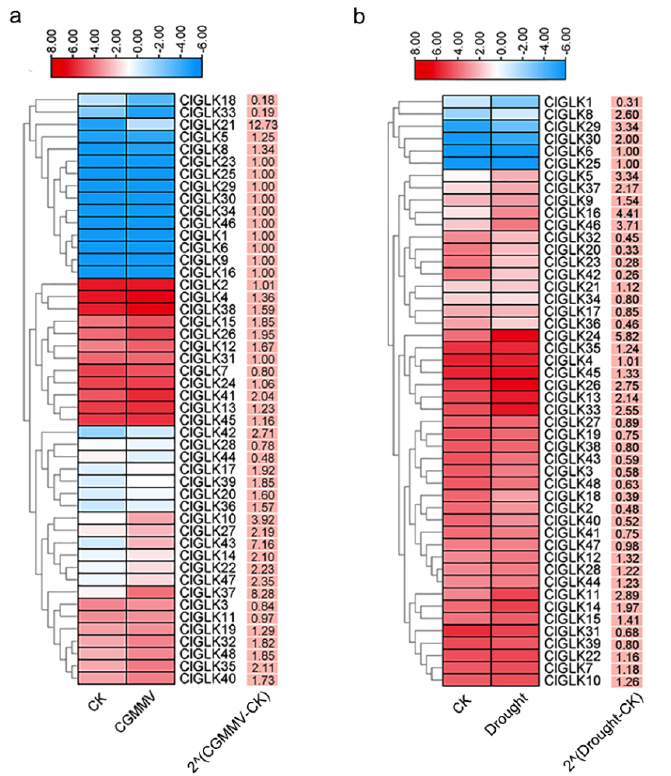
Figure 4. Expression analysis of ClGLKs under biotic and abiotic stress treatment. ( a ) The expression heatmap of ClGLKs under CGMMV infection. The data of 2 ˆ(CGMMV-CK) indicated the fold-change of the expression level of ClGLKs under CGMMV stress compared to the control. ( b ) The expression heatmap of ClGLKs under drought stress. The data of 2 ˆ(CGMMV-CK) indicated the fold-change of the expression level of ClGLKs under drought stress compared to the control.